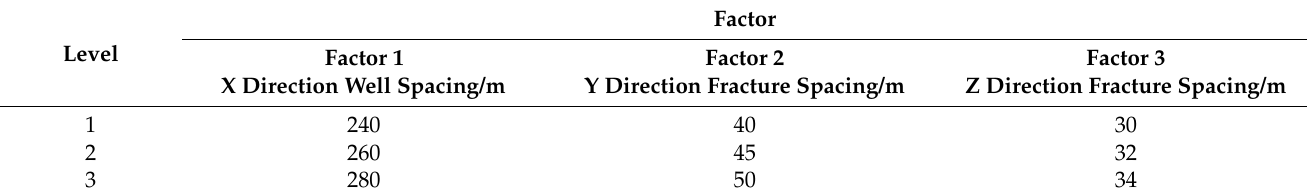
Table 6. Orthogonal design table of deviated wells.